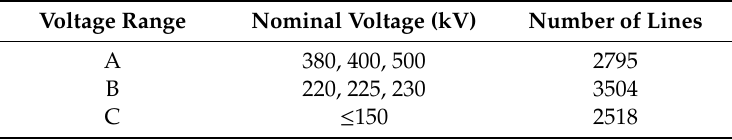
Figure 2. Perimeter of provisional network under investigation. Table 1. Number of lines by nominal voltage in the test network.